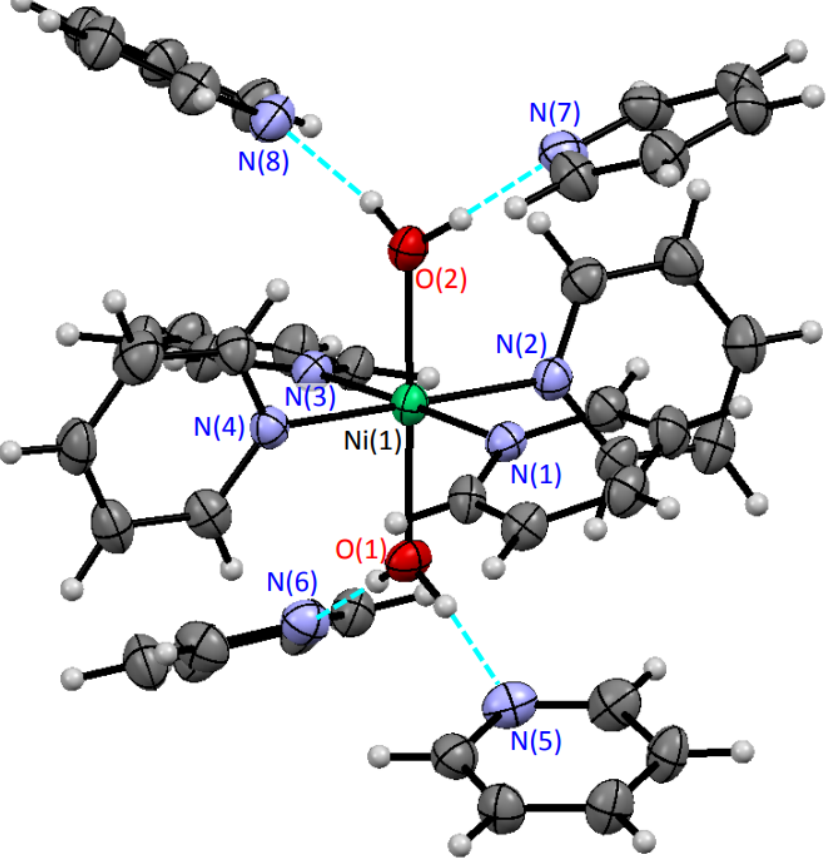
Figure 3. Crystal structure of [Ni(H 2 O) 2 (py) 4 ] 2+ ·4py unit in 1 . Thermal ellipsoids are drawn at the 50% probability level. Table 2. Selected distances for 1 .